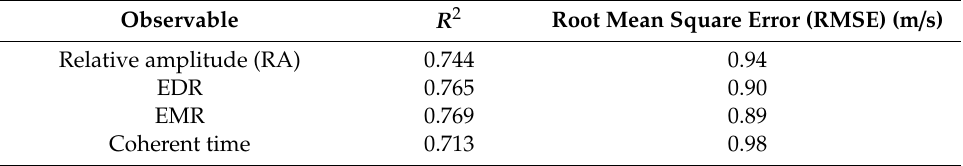
Figure 7. Scatter plots between in situ wind speed and observables in the gentle wind scenario. ( a ) RA. ( b ) Coherent time. ( c ) EMR. ( d ) EDR. EMR and EDR are computed with Threshold 2 = 0.3. The red lines are fitting curves. Table 3. Retrieval performances by different observables in gentle wind scenario.